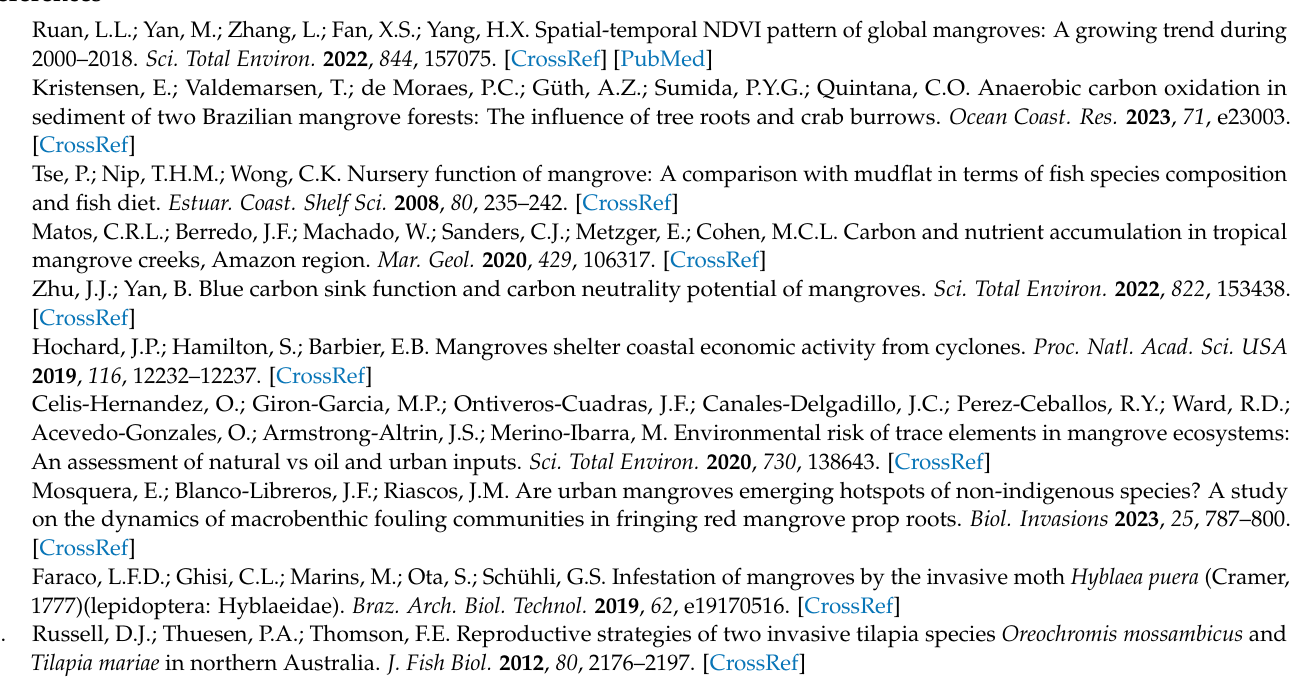
Figure S4: Linear regression of organic components of chemical characteristics of decaying leaf litter and feeding indicators of P. canaliculata ; Supplementary Table S1: Linear regression parameters of inorganic chemical characteristics of decaying leaf litter and feeding indicators of Pomacea canaliculata ; Supplementary Table S2: Linear regression parameters of organic chemical characteristics of decaying leaf litter and feeding indicators of Pomacea canaliculata